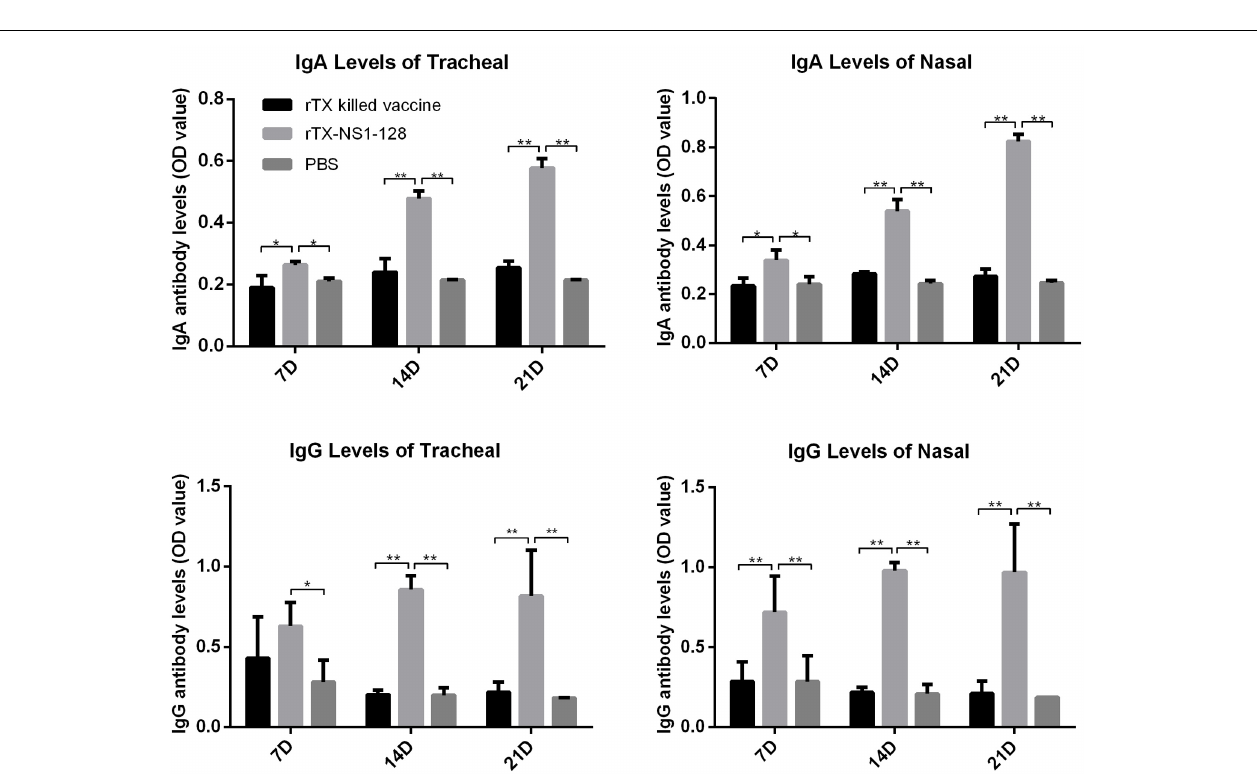
FIGURE 5 | Detection of specific IgA and IgG level in mucosa. Chickens were immunized at 4 weeks of age, and lavage fluids from the trachea and nasal tissues were sampled at 7, 14, and 21 dpi. The antibody levels were detected using ELISA. All data are shown as the mean ± standard errors. Asterisks represent p -values < 0.05. Double asterisks represents p -values less than 0.01. OD, optical